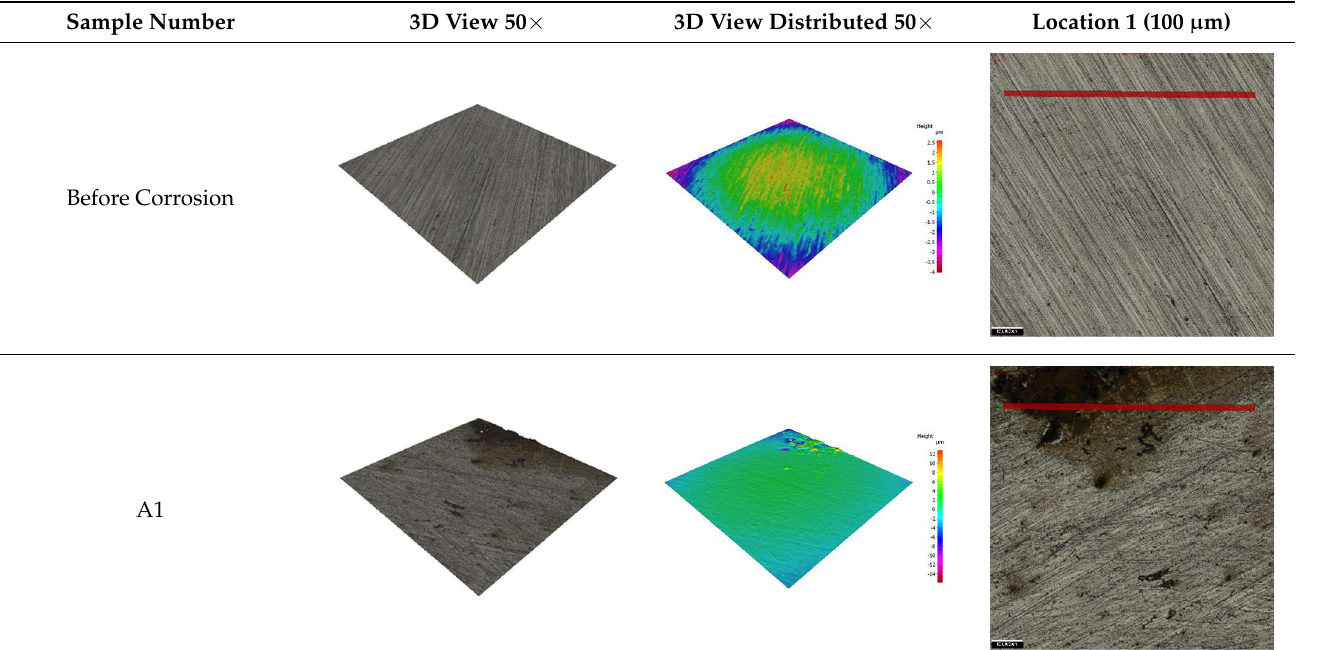
Table 6. Profile roughness images at 50 × magnification using Alicona InfiniteFocus.